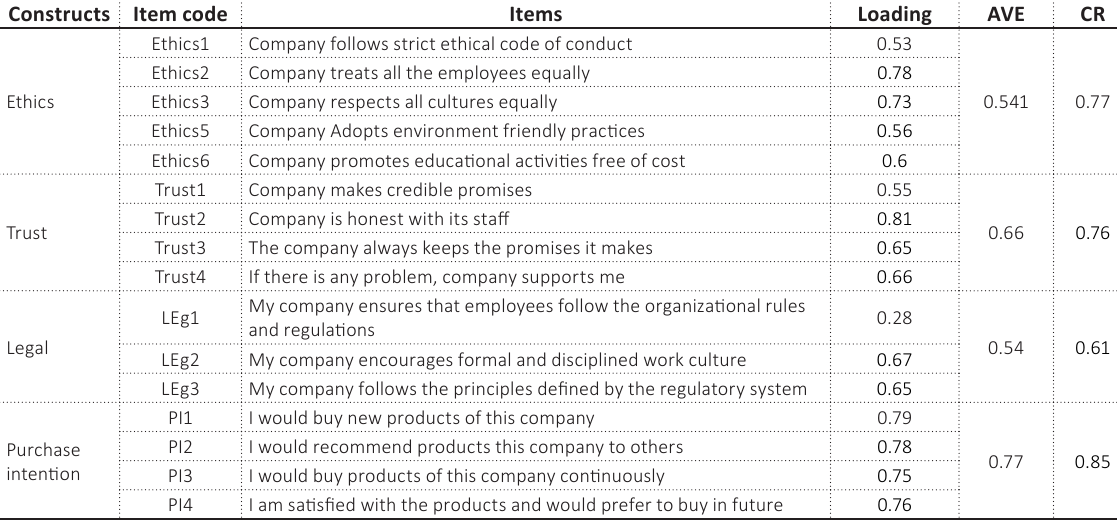
Table 2. Construct validity and reliability Constructs Item